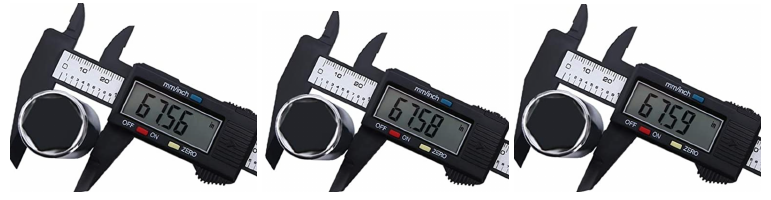
Figure 2. Three measurement results of the same value